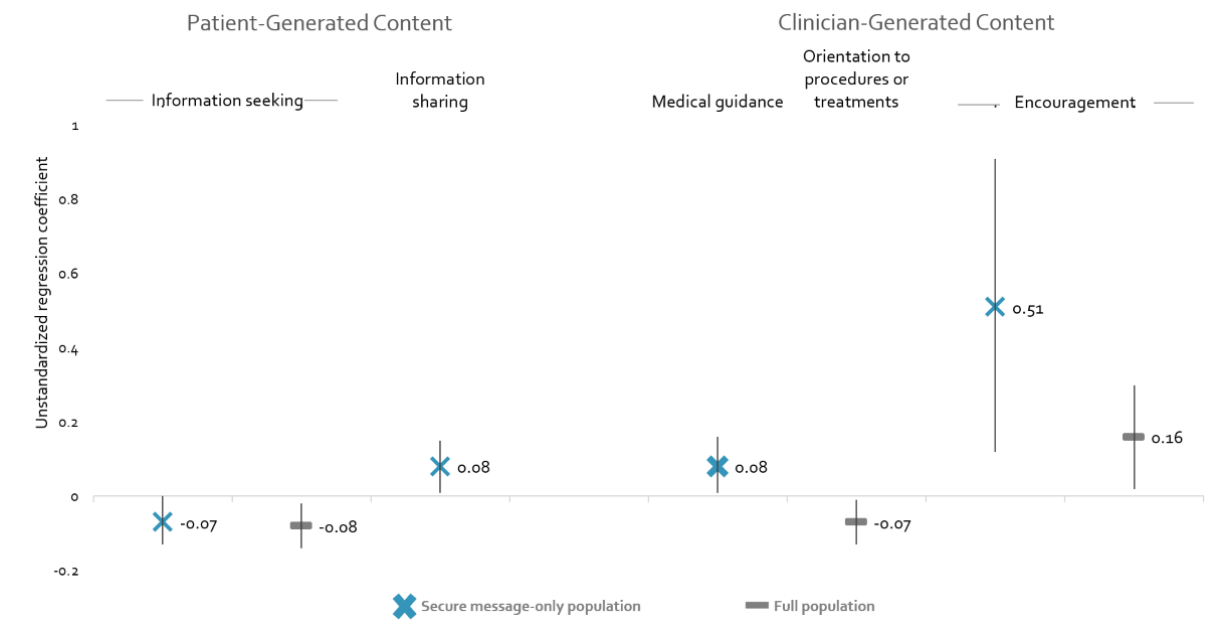
Figure 1. Associations between taxa and A1C changes.